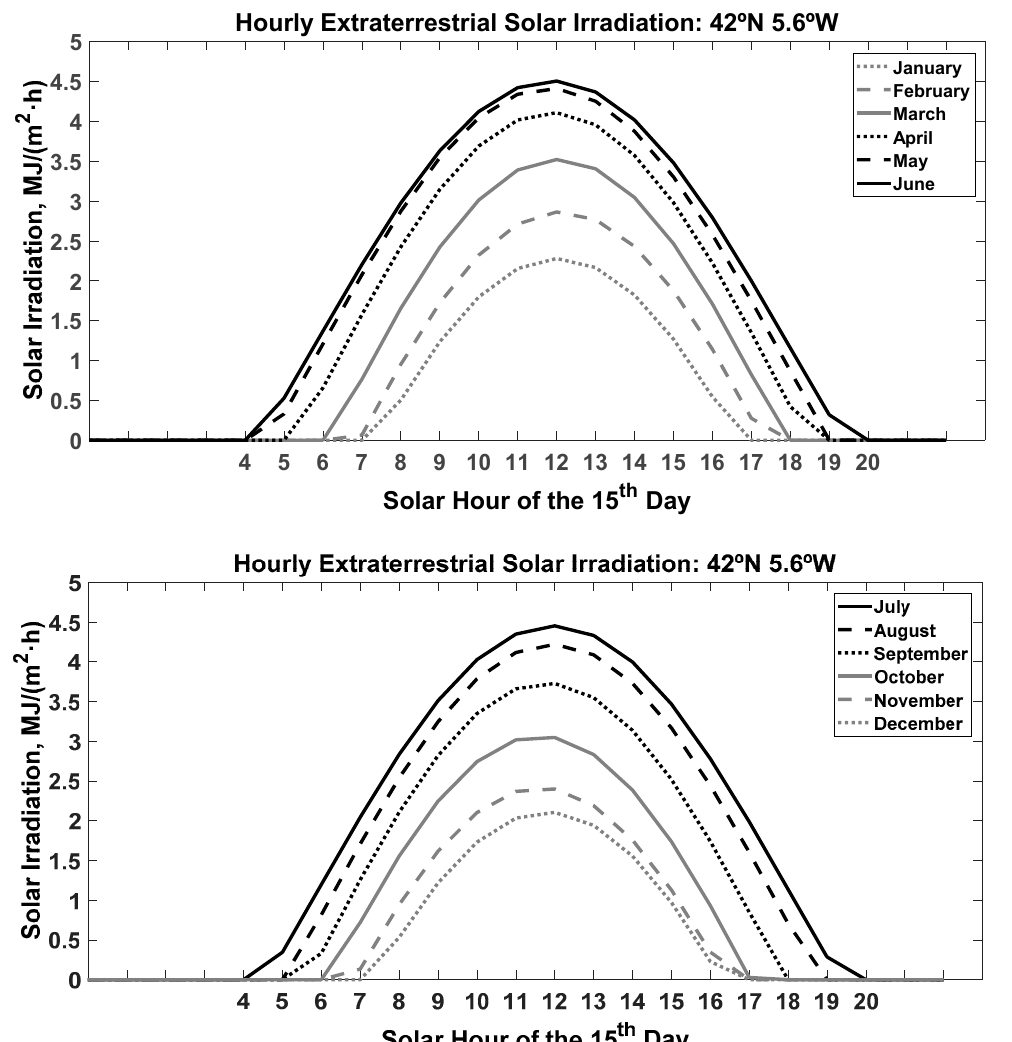
Figure 2. Hourly extraterrestrial solar irradiation calculated at latitude 42° N and longitude 5.6° W for the 15th day of each month. ( Top ) January to June; ( bottom ) July to December.